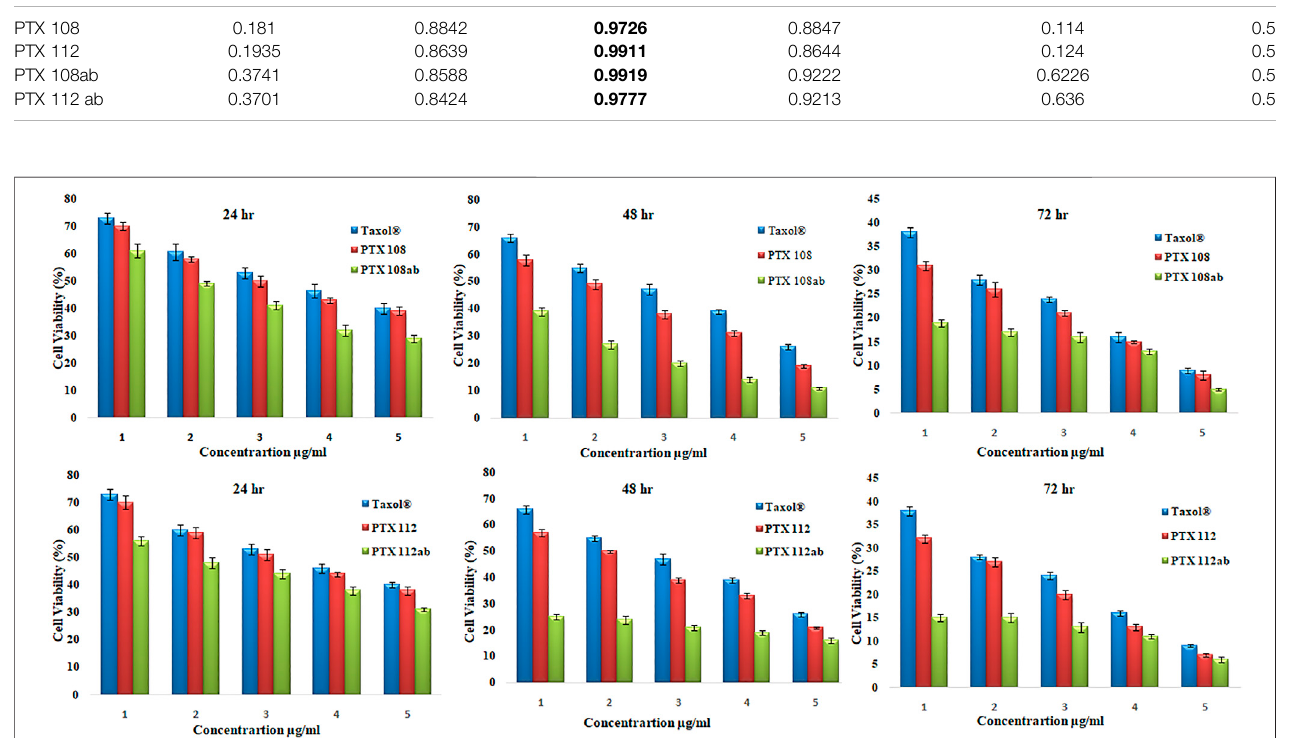
FIGURE 7 | Cell viability (%) of MCF-7 cell lines by Paclixil ® , paclitaxel-loaded PLGA nanoformulations PTX 108 and PTX 112, and antibody-conjugated paclitaxel- loaded PLGA nanoformulations PTX 108ab and PTX 112ab at 0.25, 2.5, 10, 25, and 50 μ g/ml concentration after 24, 42, and 72 h.